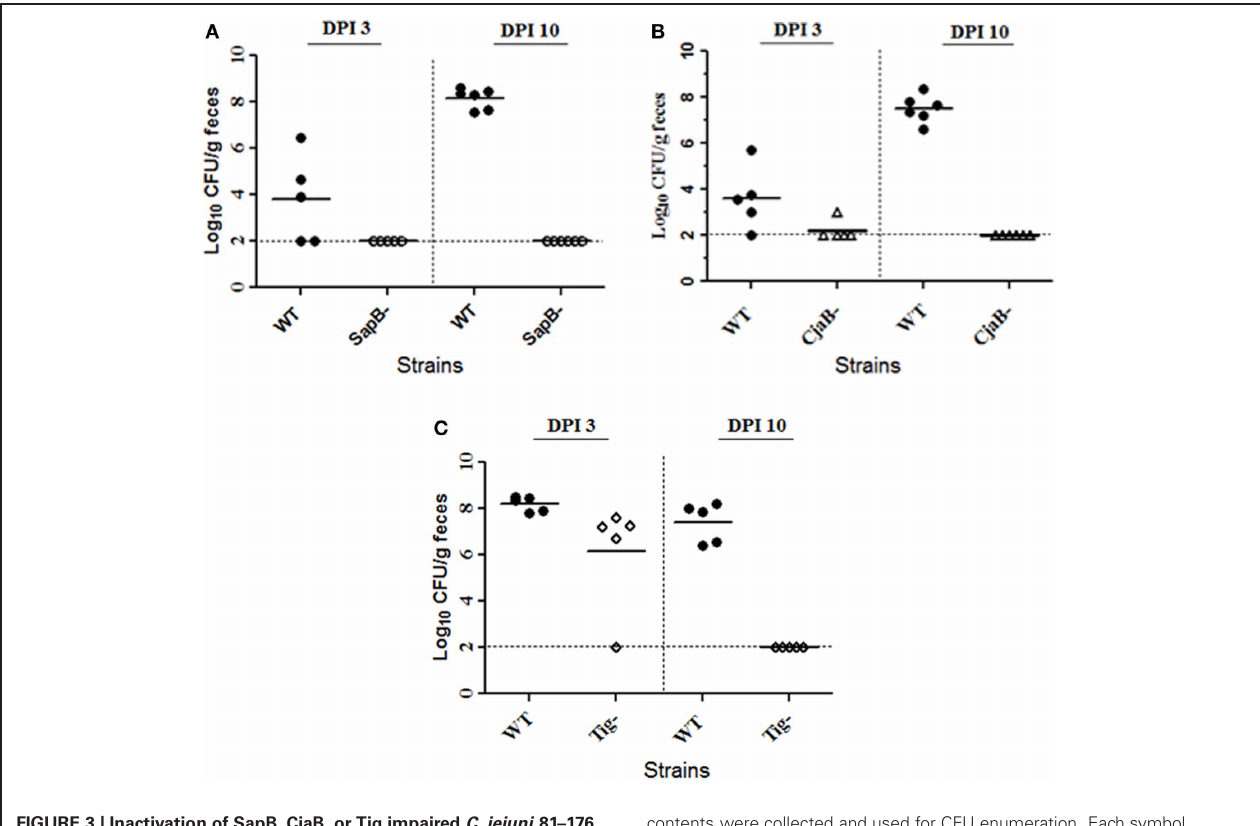
FIGURE 3 | Inactivation of SapB, CjaB, or Tig impaired C. jejuni 81–176 colonization of chickens. Three chicken groups were inoculated with a 1:1 mixture of wild type 81–176 and its isogenic SapB mutant (A) , CjaB mutant (B) , or Tig mutant (C) . For each group, five to six birds were euthanized at the indicated days post-inoculation (DPI) and the cecal